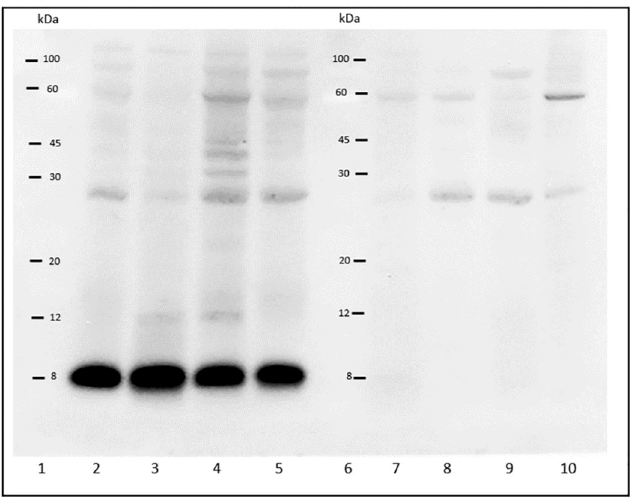
Fig 3. Representative western blot analysis of bile samples with anti-SAA1 polyclonal antibody. Lane 1 and 6: pre- stained molecular weight markers; lane 2–5: positive samples; lane 7–10: negative samples.